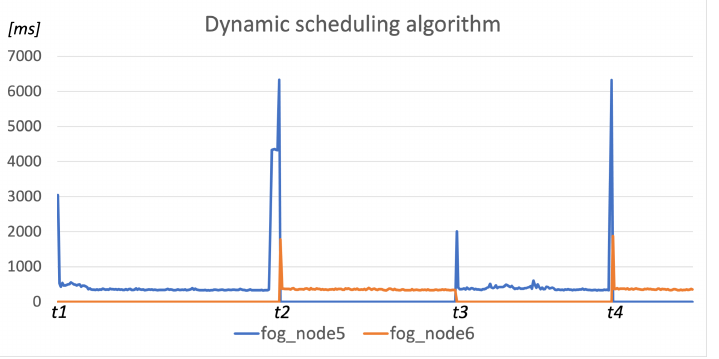
Figure 8. Request-response latency in automation service scenario simulation (dynamic scheduling